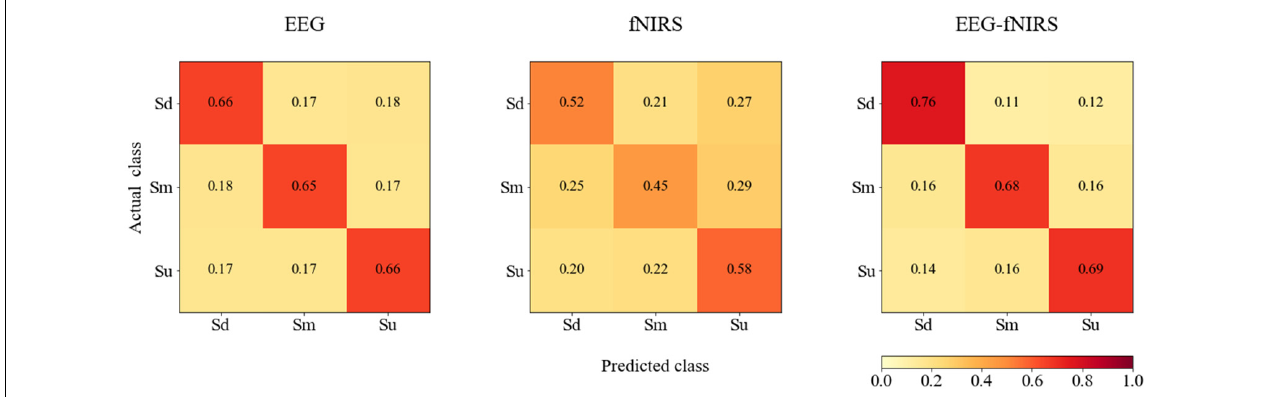
FIGURE 12 | The averaged confusion matrices for EEG, fNIRS and EEG-fNIRS classifications for all participants.